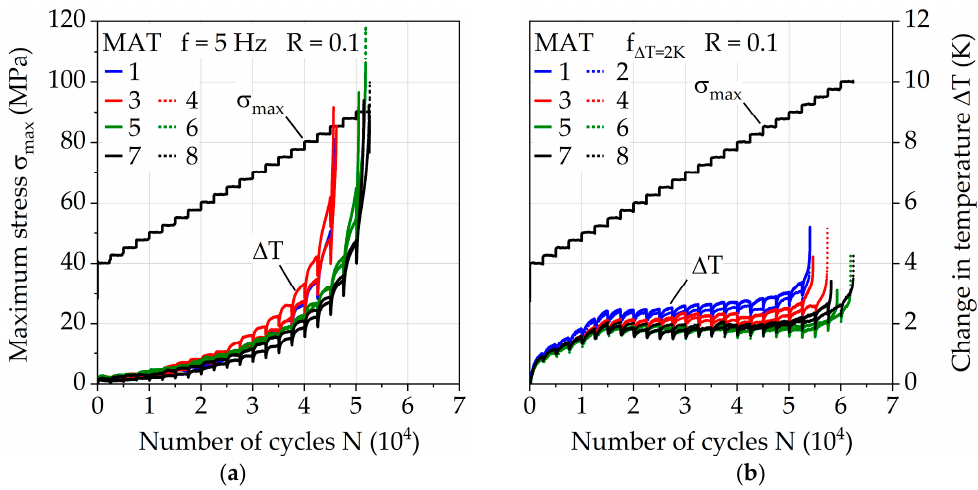
Figure 9. Change in temperature in multiple amplitude tests with ( a ) constant testing frequency of 5 Hz and ( b ) adjusted testing frequency for a constant change in temperature Δ T of 2 K.